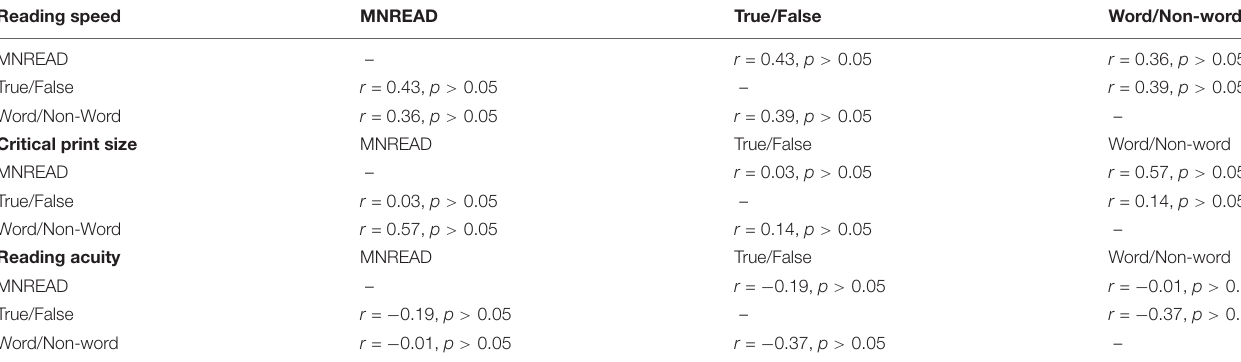
TABLE 1 | Correlations between parameters estimated for each reading task. Pearson correlation coefficient and p -value reported for each